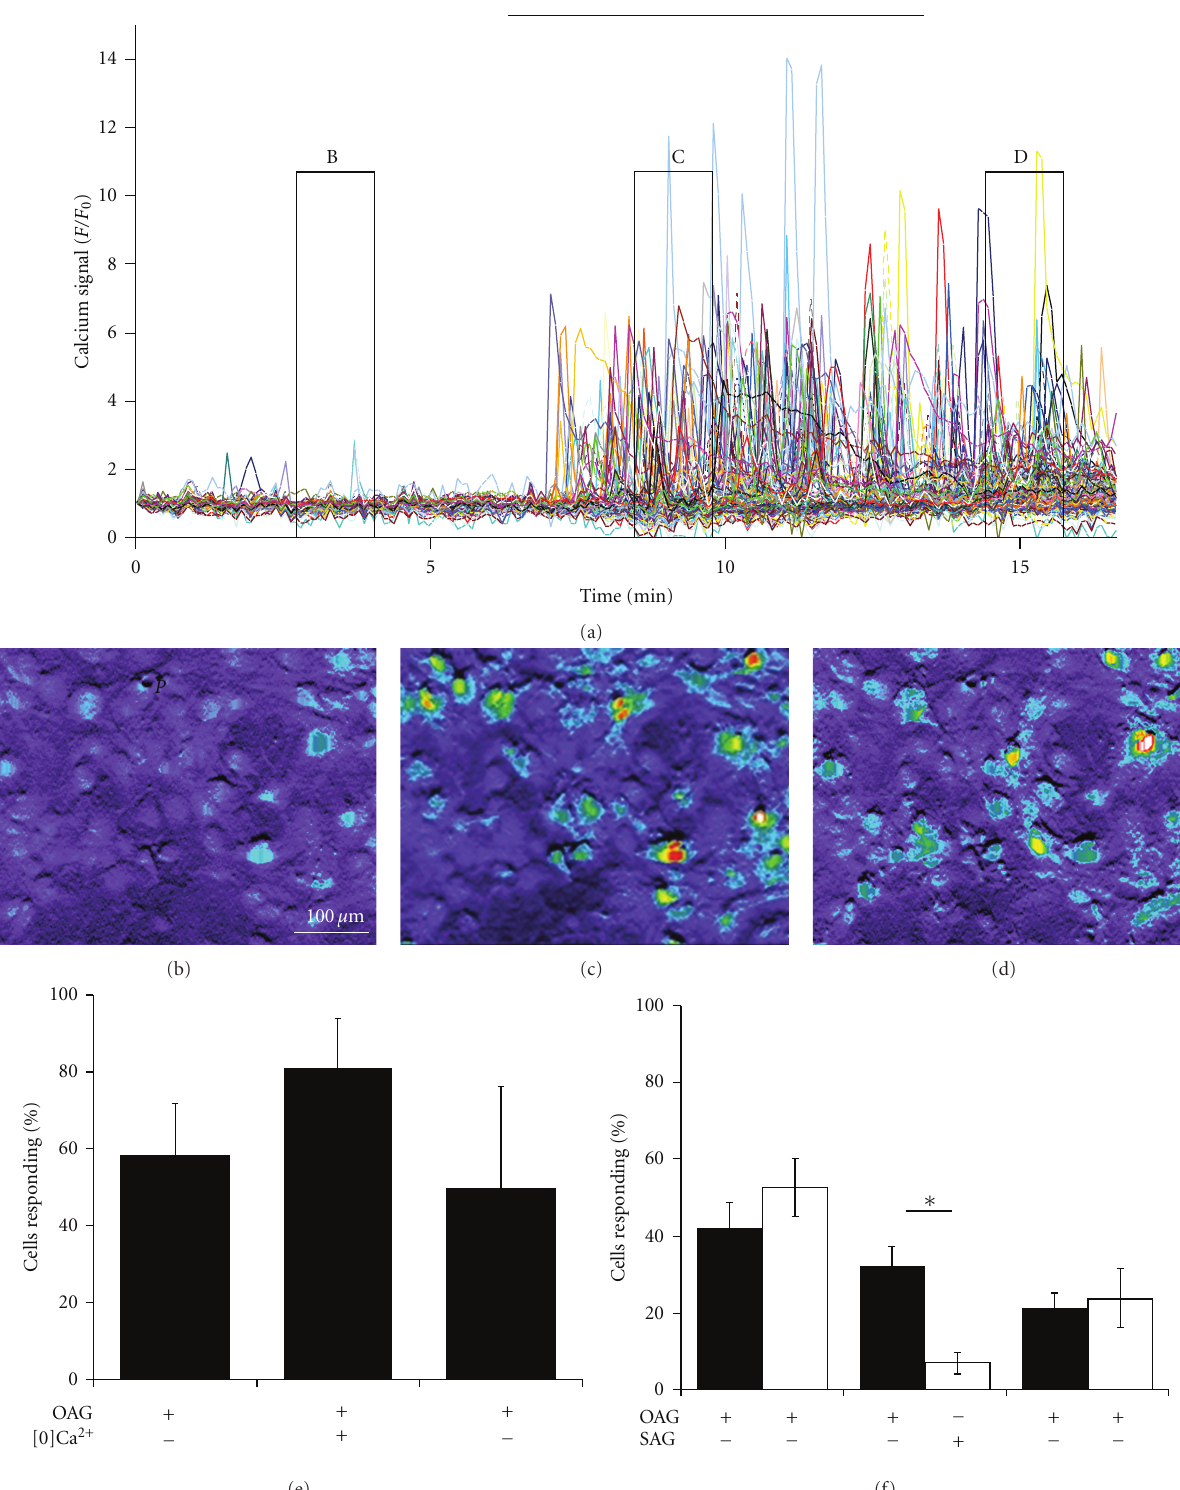
Figure 1: The diacylglycerol analogue 1-oleoyl-2-acyl-sn-glycerol (OAG) induces calcium oscillations in astrocytes that are not dependent on external calcium. (a) Cultured cortical astrocytes respond to 100 µ M OAG with robust calcium oscillations. (b) Astrocytes imaged in culture in a perfusion system have little background calcium activity as imaged with Fluo4. (c) The addition of 100 µ M OAG causes increases in the Fluo4 signal in discrete astrocytes but does not result in a calcium wave. (d) Astrocyte calcium oscillations continue for several minutes after the OAG-containing medium is washed away. (e) Calcium oscillation in response to 30 µ M OAG is not reduced in the presence of nominally ( ∼ 60 nM) calcium-free external medium ( P = 0 . 25, n = 5). (f) The astrocyte response to 30 µ M OAG is significantly greater than the response to the less cell-permeable DAG analogue 1-stearoyl-2-arachidonyl-sn-glycerol (SAG, 30 µ M) ( P = 0 . 0002, control n = 14, SAG n =